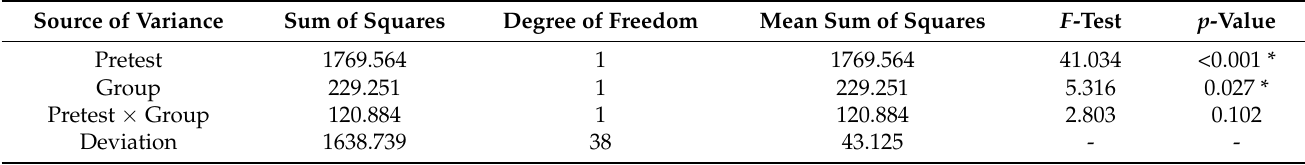
Table 4. Test of intra-group homogeneity of the within-group regression coefficients.